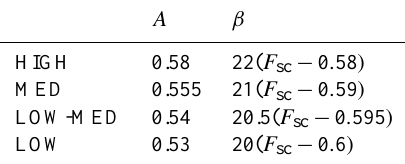
Table 2. Permafrost area model settings for Eq.